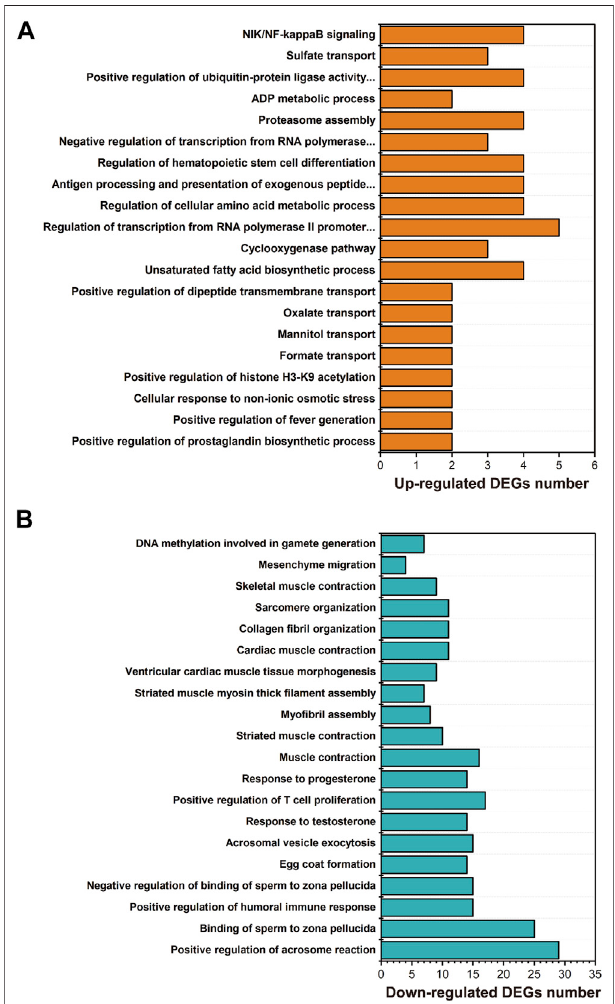
FIGURE 3 | Results of GO enrichment with differentially expressed genes in the larval Ietalurus punetaus after 48 h of exposure to 50 mg/L polystyrene nanoplastics. (A) the biological process categories enriched with upregulated genes. (B) the biological process categories enriched with downregulated